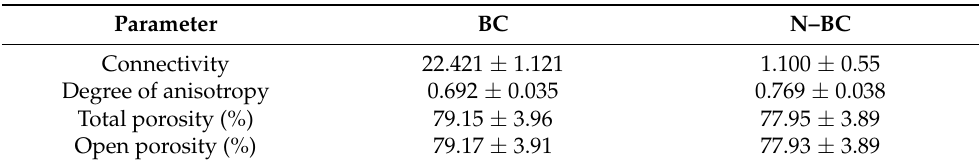
Table 3. X-ray microtomography parameters of the bacterial cellulose (BC) and the bacterial cellulose with nisin (N–BC)